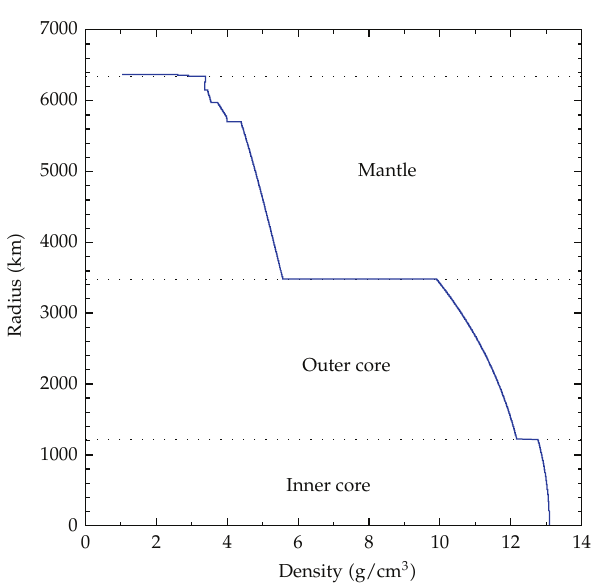
Figure 9: Depth dependence of density as given by PREM (cid:3) 125 (cid:4) .